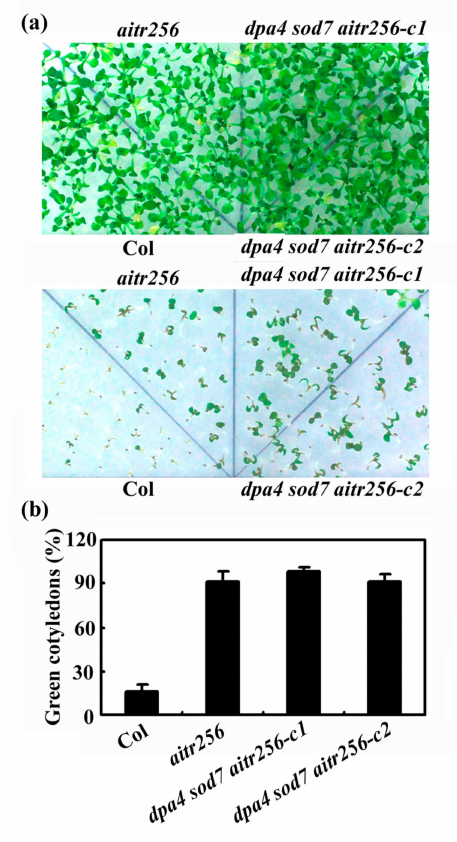
Figure 3. ABA sensitivity of the dpa4 sod7 aitr256 quintuple mutants. ( a ) ABA sensitivity of the Col wild type, the aitr256 triple and the dpa4 sod7 aitr256 quintuple mutants. Seeds were sterilized and then plated on 1 / 2 MS plates with 2.5 µ M ABA, or without ABA as a control. The plates were kept at 4 ◦ C in darkness for 2 days before transferred to a growth room. Pictures were taken 17 days after the transfer. Upper panel, without ABA, lower panel, with ABA. ( b ) Quantitative of green seedlings of the Col wild type, the aitr256 triple and the dpa4 sod7 aitr256 quintuple mutants in response to ABA treatment. Seedlings with green cotyledons were counted after the pictures were taken. Data represent the mean ± SD of three